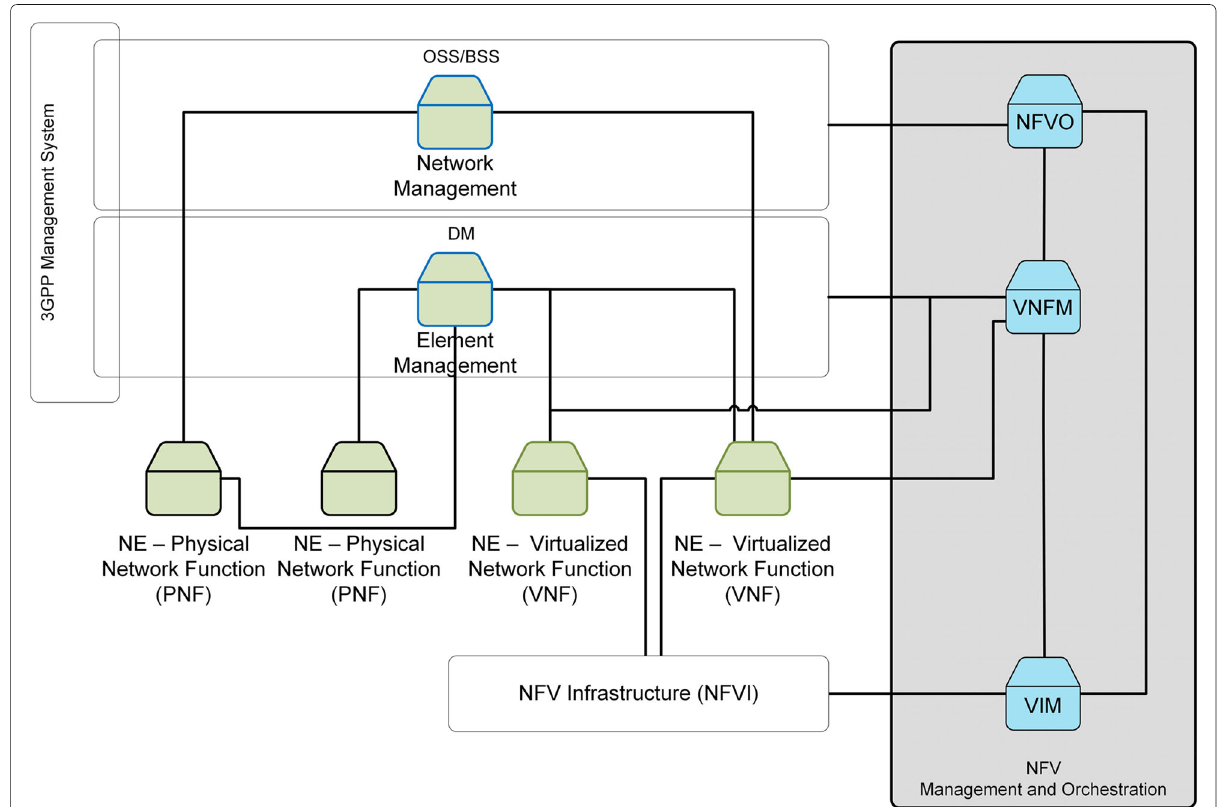
Fig. 9 Mapping between ETSI NFV-MANO and 3GPP for managing cellular networks. The proposed management and orchestration works